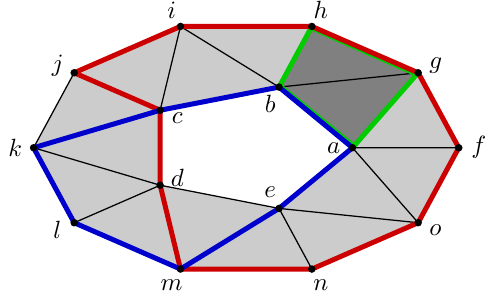
Figure 2. Different kind of cycles: a blue cycle is relevant and span the homology group H 1 ; a green cycle is irrelevant because it surrounds no hole as it can be collapsed; a red cycle is equivalent to the blue cycle as it can be transformed into it while staying in the